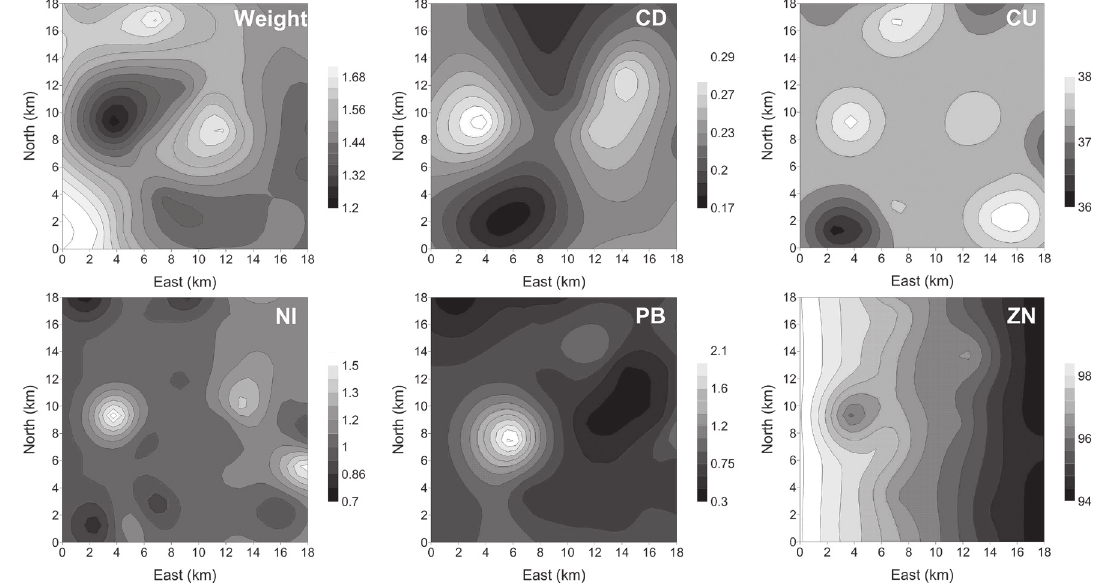
Fig . 4. – mapped spatial distribution of weight ( mbww = mean body wet weight of shrimps per sample in g), Cd , Cu , ni , Pb and Zn in Crangon crangon (mg kg -1 dW, respectively) within Box a (Fig. 1) in universal kriging plots showing contour lines.